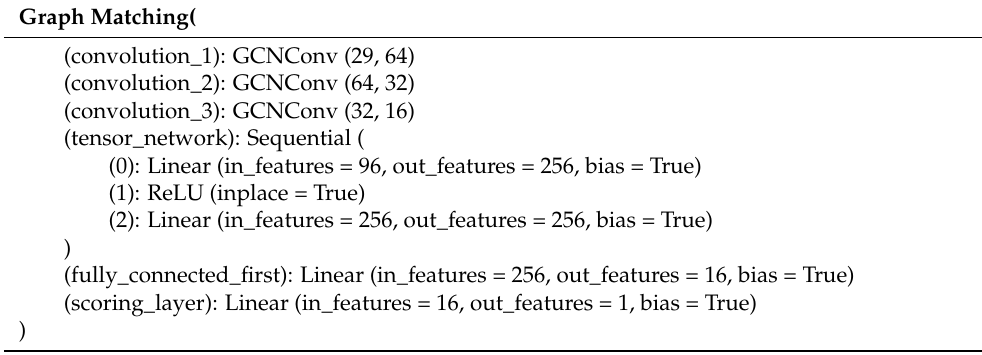
Table 2. Construction of the graph matching